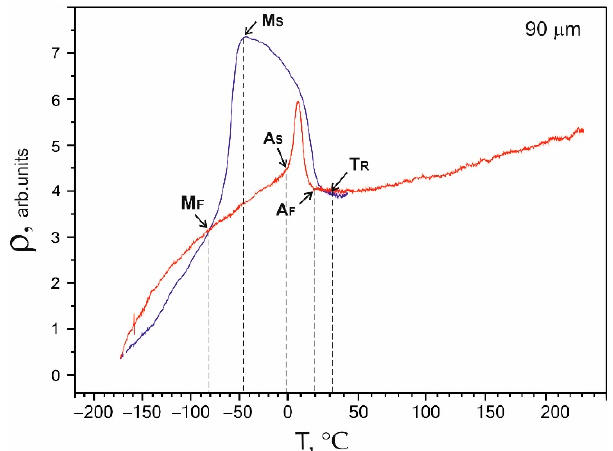
Figure 6. Temperature dependence of electrical resistivity ρ (T) for a 90 µm thick sample.